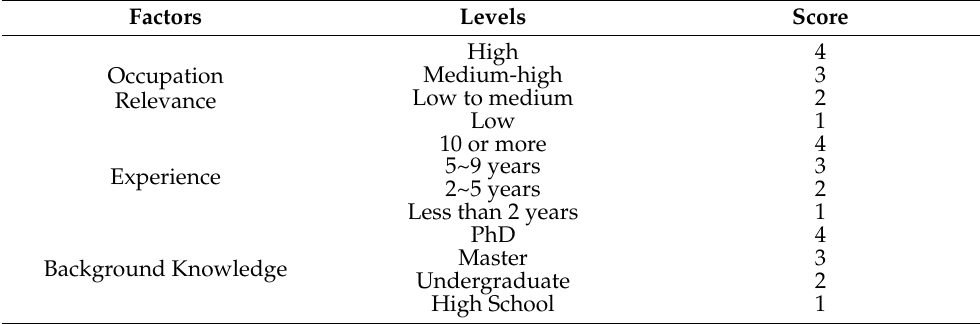
Table 2. Expert weight distribution